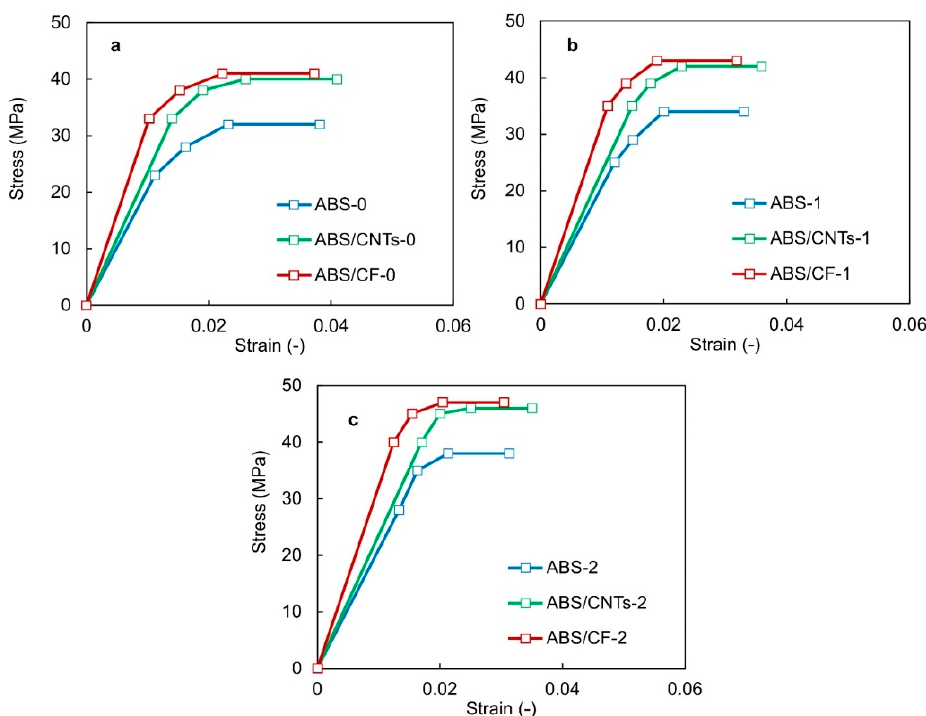
Figure 8. Comparison of the stress-strain curves for ( a ) regular honeycomb, ( b ) 1st level of hierarchy and ( c ) 2nd level of hierarchy for different materials: ABS, ABS/CNTs and ABS/CFs.